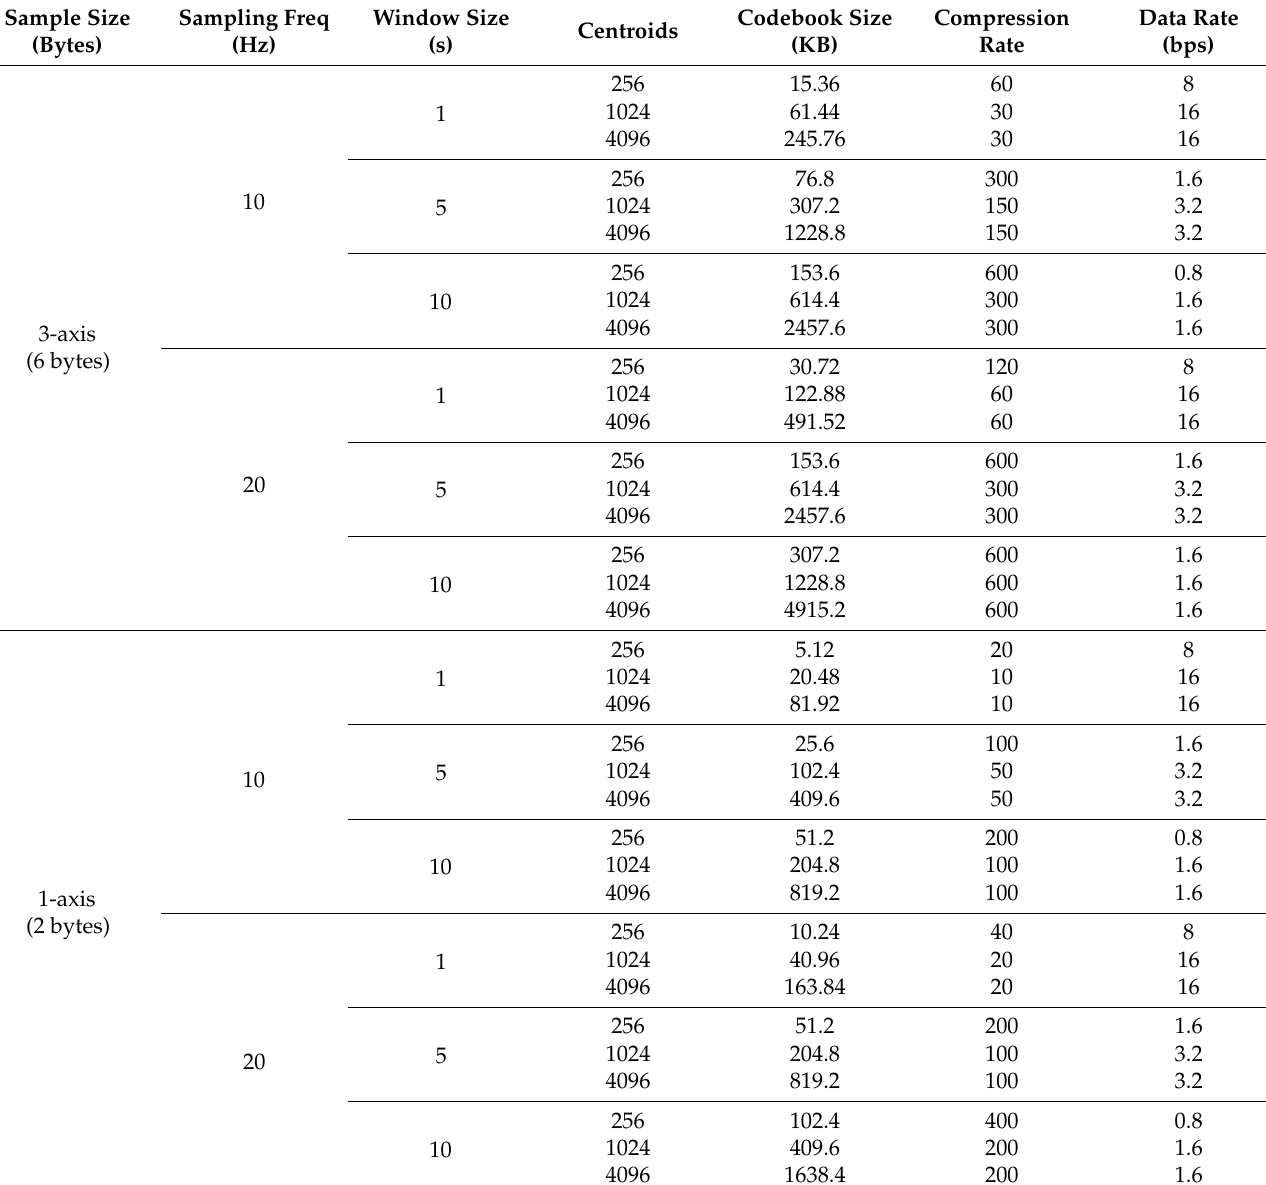
Table 3. Compression ratio and codebook size vs. codebook